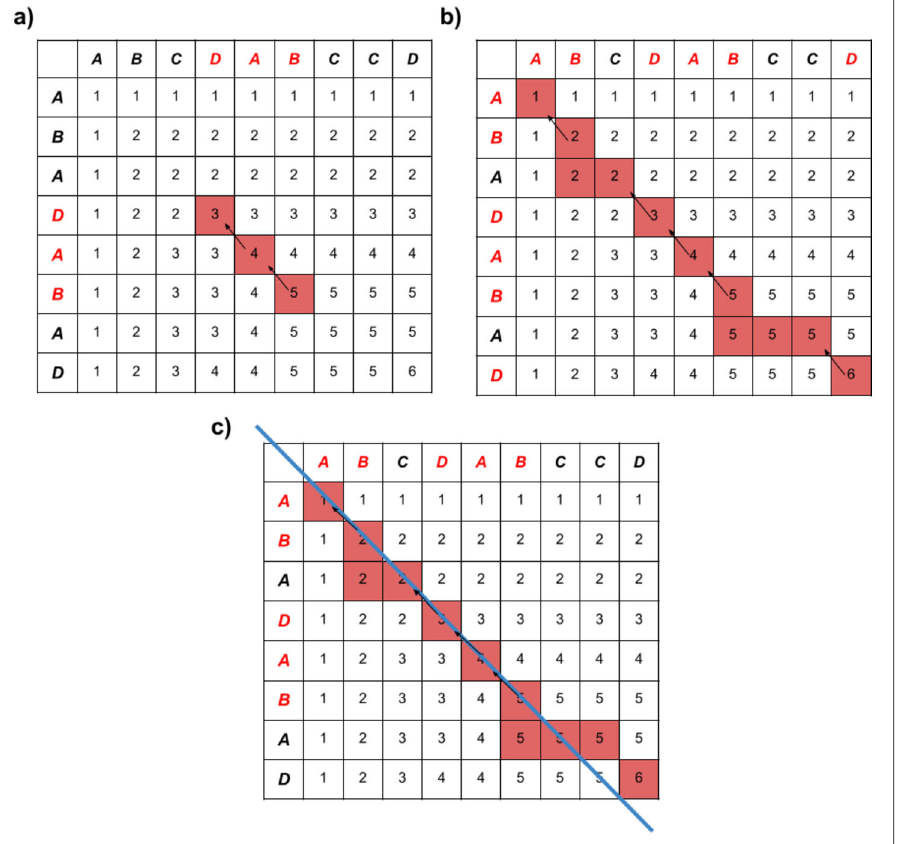
Figure 4 Visualisation of three variants of the longest common subsequence problem. Three score matrices represent scoring for the same pair of sequences. The longest common subsequence is chosen differently in each variant. Picture ( a ) shows the denserepeatabilitymetric , picture ( b ) represents the sparserepeatability metric, and picture ( c ) shows the equallysparserepeatabilitymetric , where the blue line indicates the